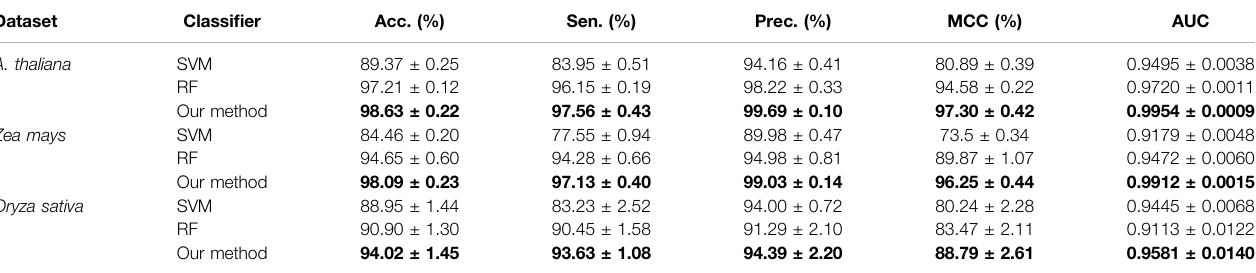
TABLE 4 | The fi vefold cross-validation results achieved by different classi fi ers on the three plant datasets. Dataset Classi fi er Acc. (%) Sen.